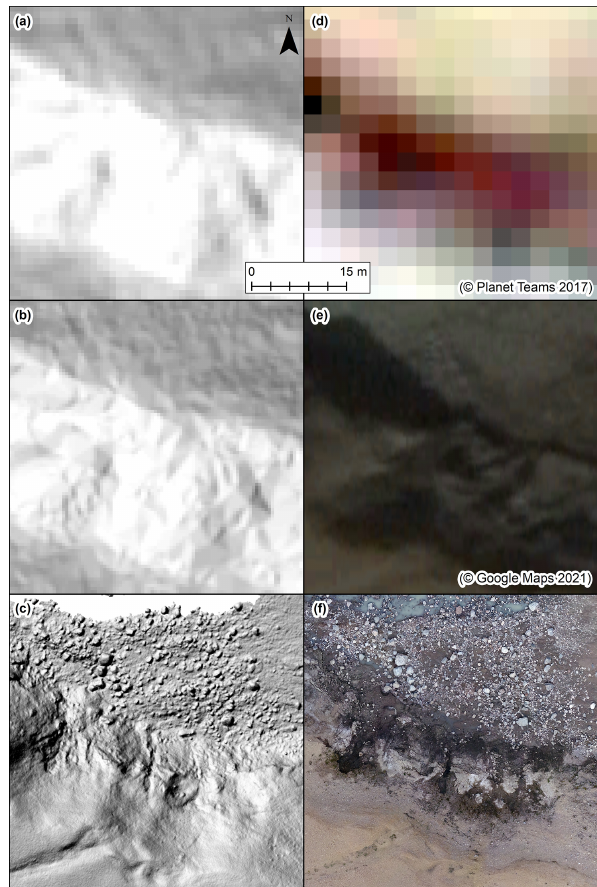
Figure 2. Comparison of different data sources and their potential for mapping geomorphological features: (a) hillshade model 1m GSD; (b) hillshade model 0.5m GSD; (c) hillshade model 0.04m GSD (generated from UAV-captured images); (d) Planet satellite imagery 3m GSD (Planet Team, 2017); (e) high-resolution satellite image 0.5m GSD (© Google Maps 2021); (f) orthomosaic 0.02m GSD (generated from UAV-captured